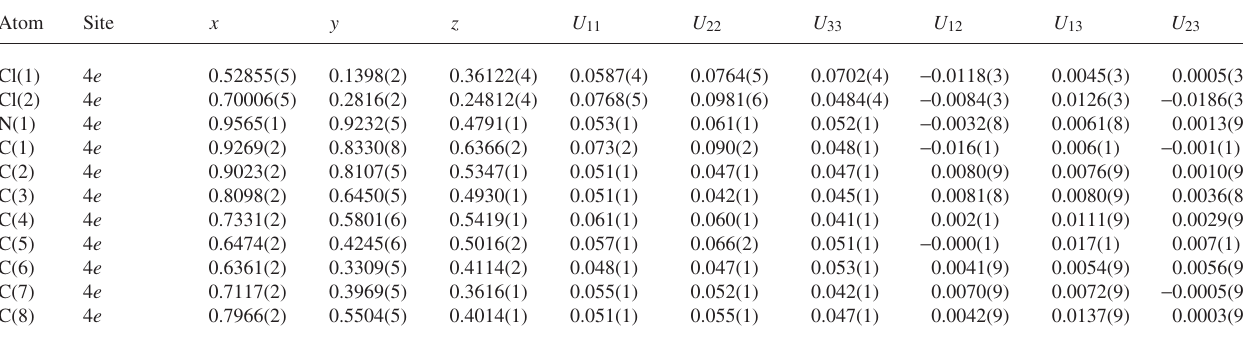
Table 3. Atomic coordinates and displacement parameters (in Å 2 )